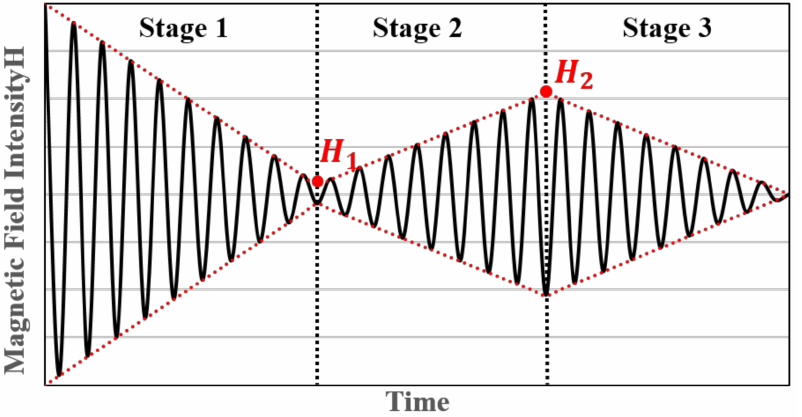
Figure 8. Flash-D